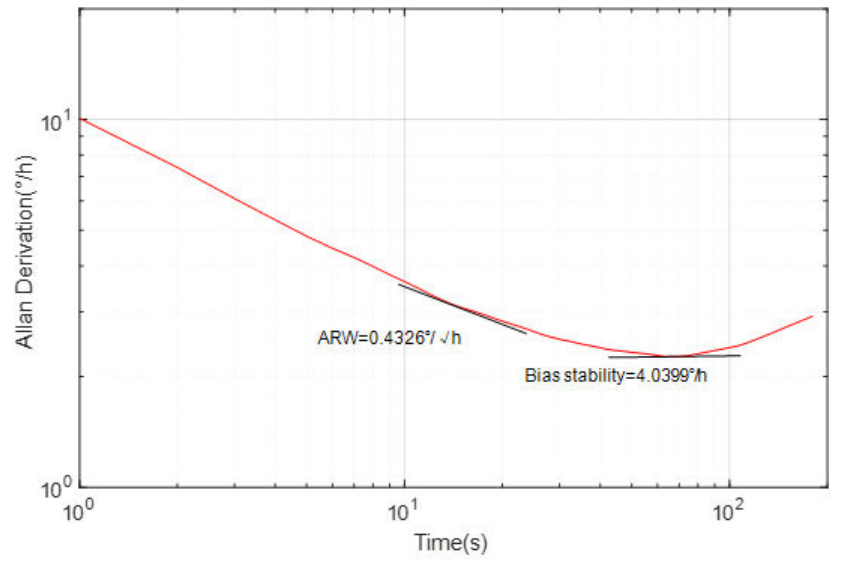
Figure 25. Allan derivation